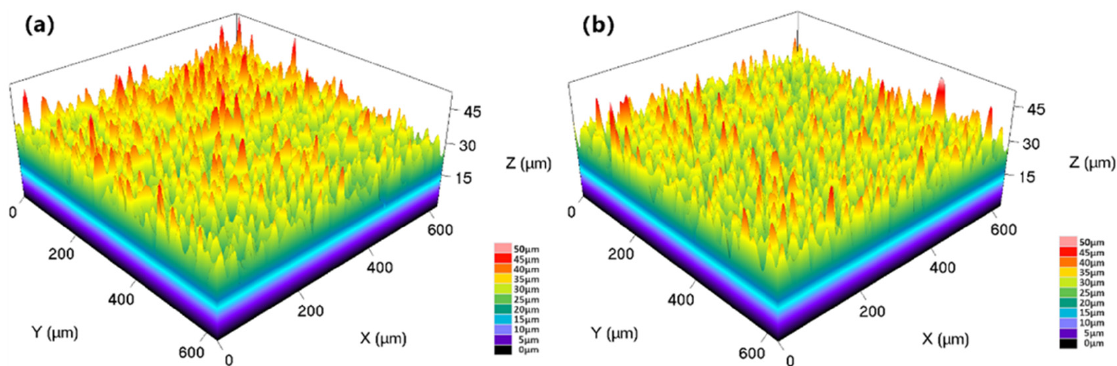
Figure 3. Three-dimensional images of the ( a ) chromized T9 steel surface and ( b ) chromized SPCC steel